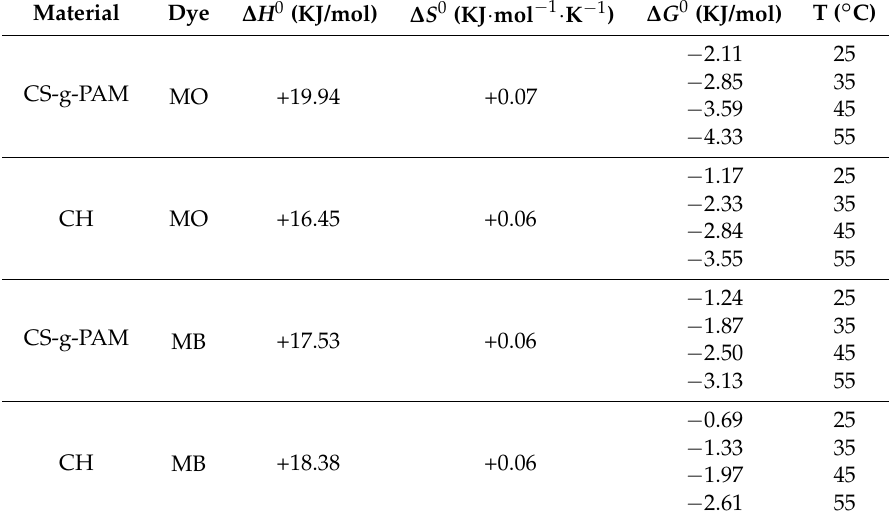
Table 3. Thermodynamic parameters for the decolorization of MB and MO by chitin and chitosan-g-PAM (pH 8.0 for MB and 5.0 for MO; initial MB/MO concentration: 4.0 mg/L; mass of CH and CS-g-PAM: 0.3 g · 100 mL − 1